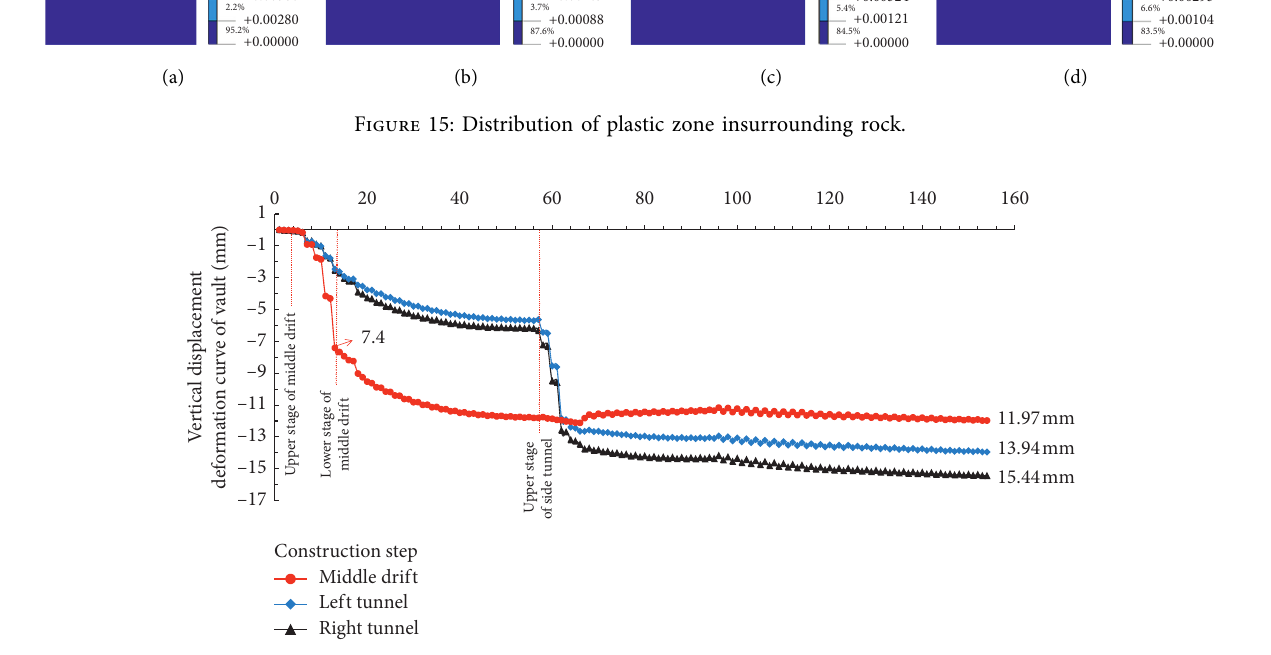
Figure 16: Settlement curve of RK0+300 arch crown.